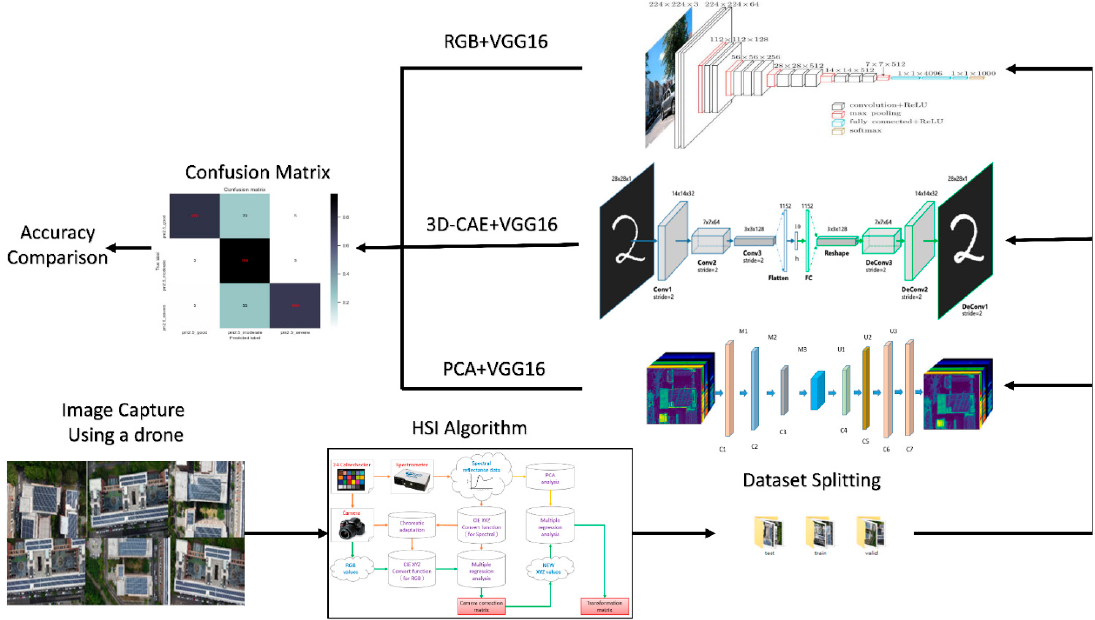
Figure 2. The methodology used in this study.